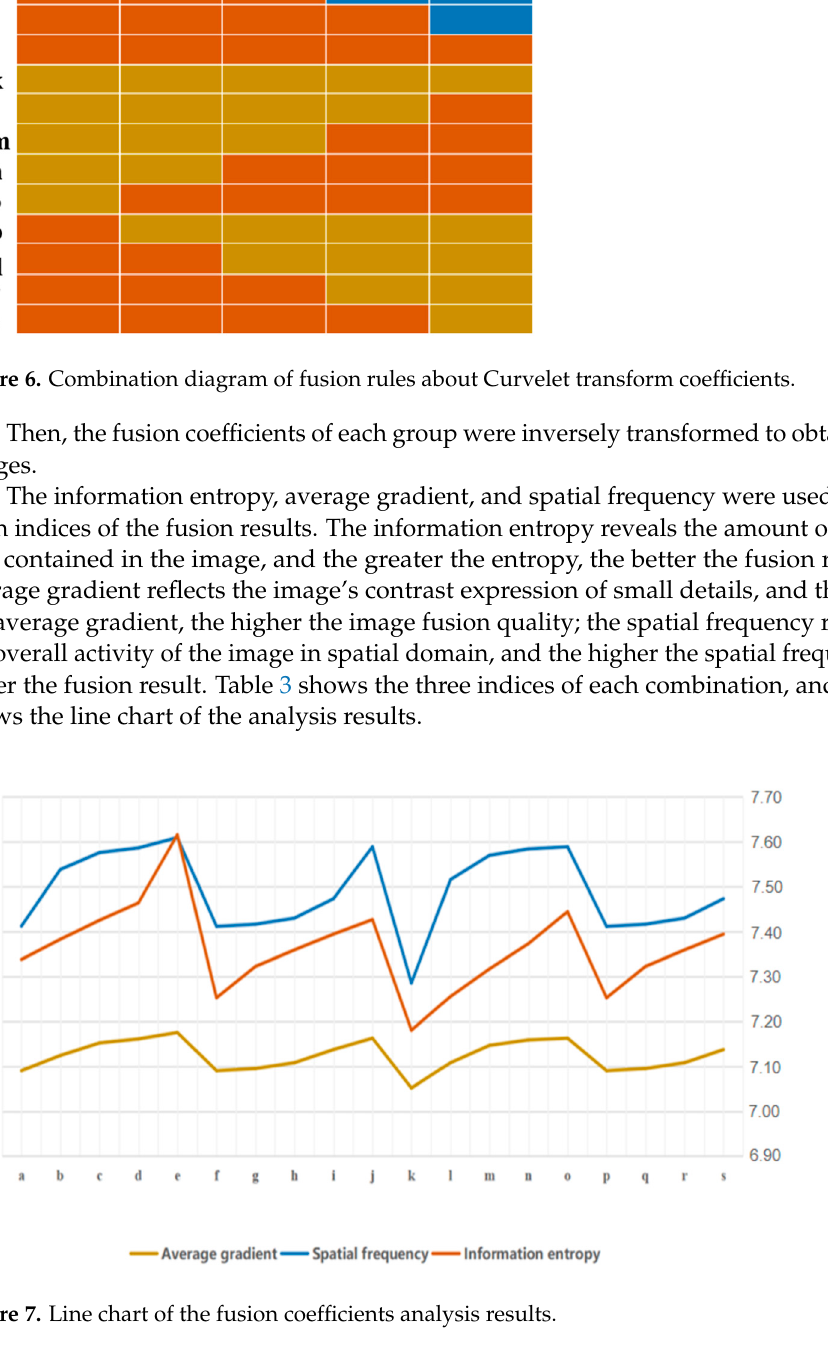
Table 3. Comparison of fusion effects in different combinations.